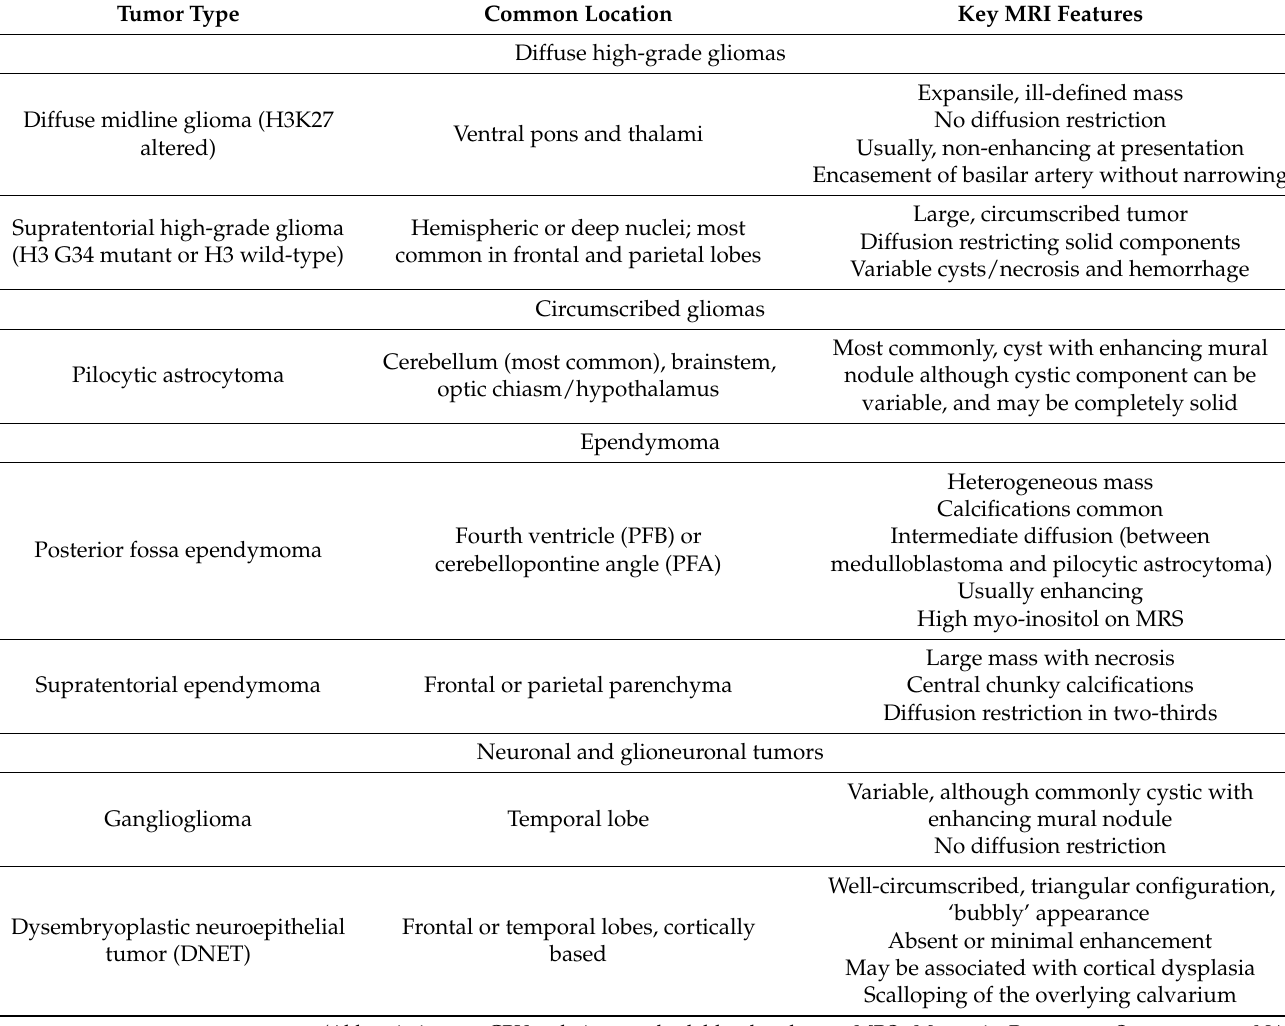
Table 2. Summary of key imaging features of glial and glioneuronal